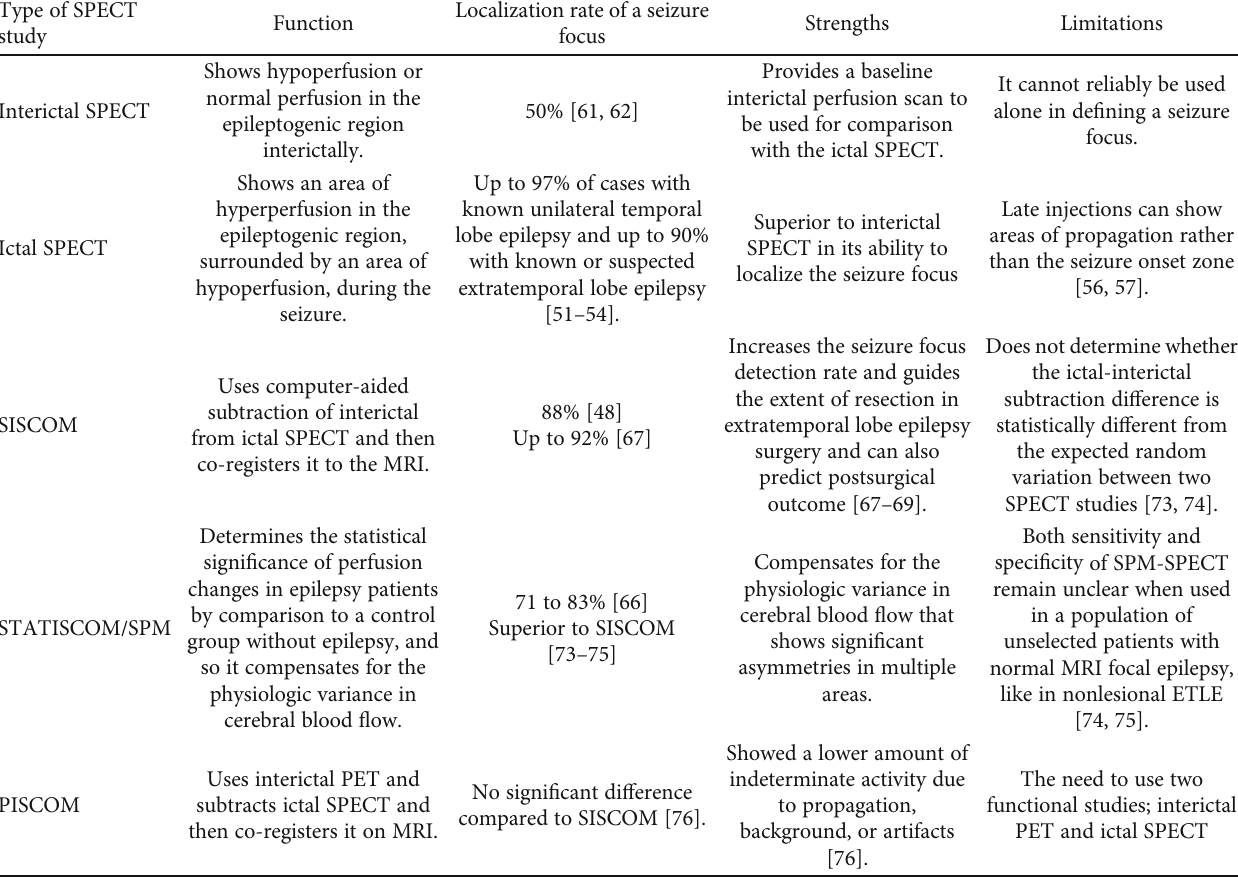
Table 1: Summary of the function and localization ability of all the functional imaging